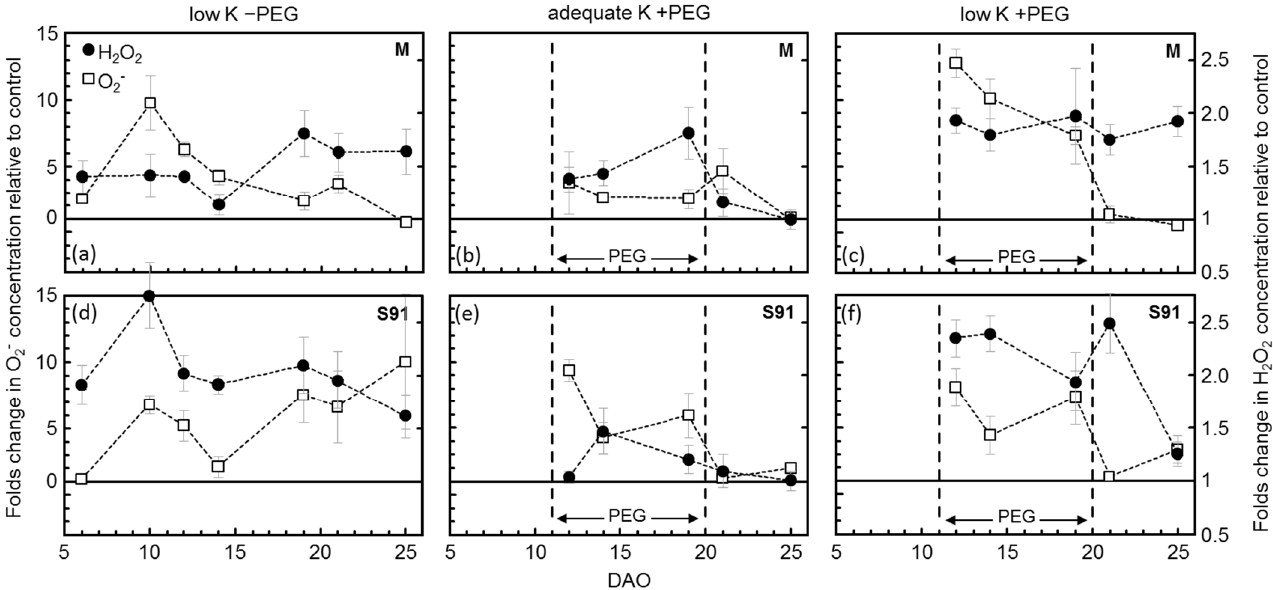
Figure 2. Temporal course of H 2 O 2 and O 2 − concentration in the youngest fully expanded young leaves of two barley cultivars (Milford, M ; Sahin-91, S91 ) grown in the nutrient solution under two levels of K supply (adequate K: 0.8 mM K + ; low K 0.04 mM K + ) without and with a PEG-induced water deficit ( − PEG; +PEG) 5–25 days after the onset of K treatments (DAO). The letters (a) to (f) represent each single combination of K-level x PEG-level x barley-variety. On each sampling day, values of the treatments “low K − PEG”, “adequate K +PEG” and “low K +PEG” are expressed as fold changes in comparison to control (“adequate K − PEG” = 100%, represented by the solid hori- zontal line in each plot). Symbols represent means ± SE ( n = 6). Significant differences of the meas- urements are provided in the appendix (Table A1—continued).